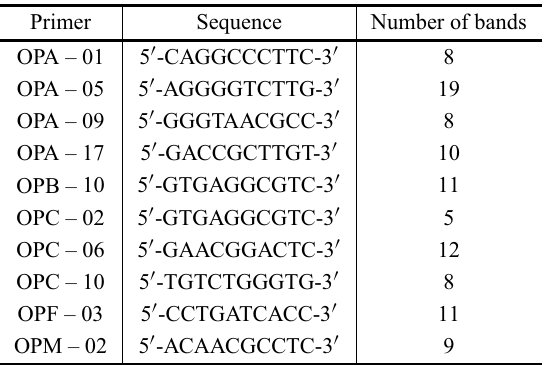
Number of RAPD loci for Chlosyne lacinia saundersii .